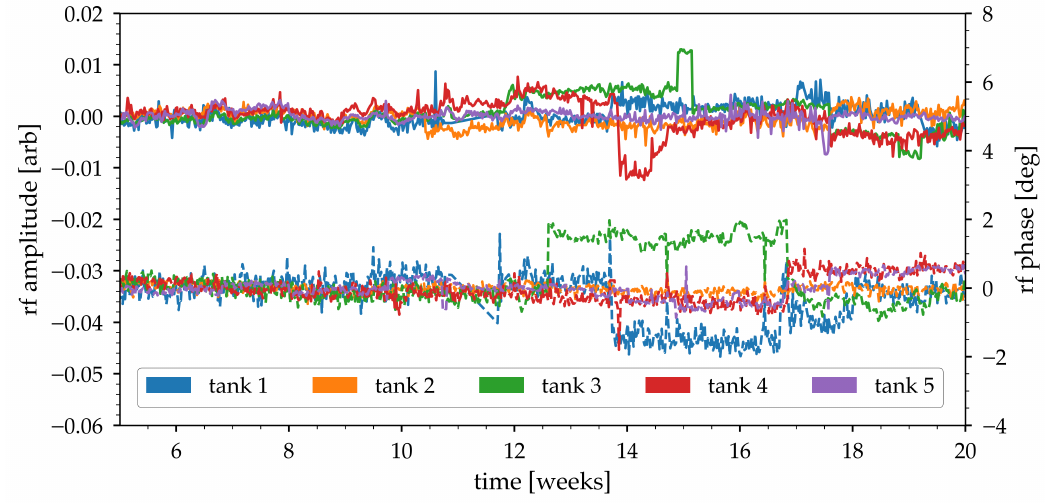
Figure 5. Raw RF amplitude (top) and phase (bottom) for each of the five DTL tanks during the whole operational period. Note phase measurements are not available when the RF is off.